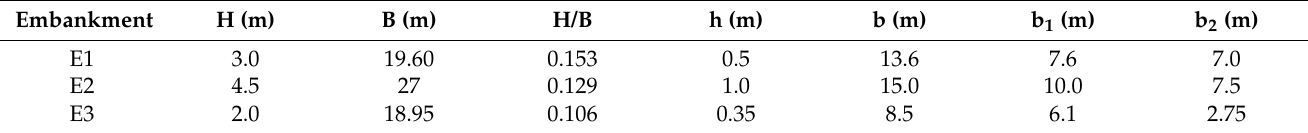
Figure 3. A geometric scheme of the considered railway embankments. Table 3. Geometrical specifications of the selected embankments.